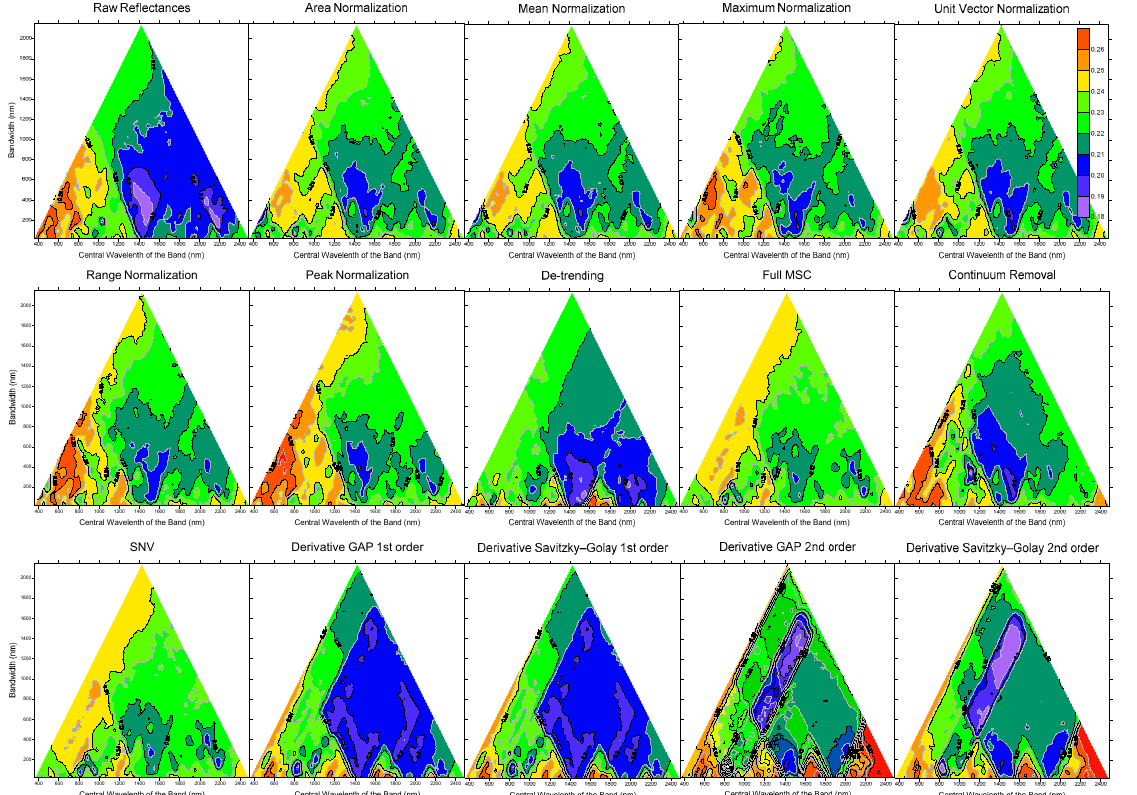
Figure 7. RMSE values for water potential (MPa) obtained by PLSR using raw reflectance data and after pre-processing (area, mean, maximum, unit vector, range, and peak variants of normalization, de-trending, MSC, CR, SNV, and GAP and Savitzky–Golay first- and second-order derivatives). All graphs apply the same colour scale (see legend in the top-right corner).